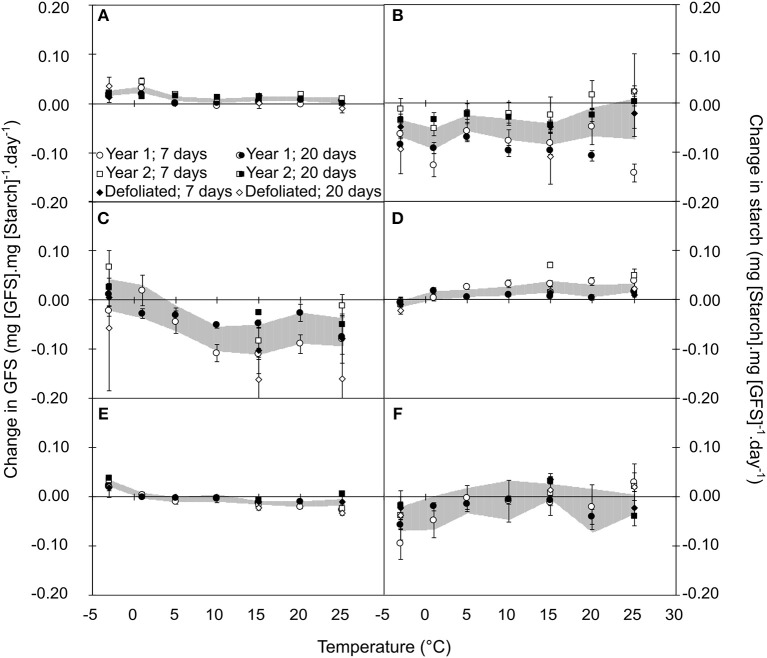
Relative variation in GFS (A,C,E) and Starch (B,D,F) normalized by Starch and GFS, respectively, after 7 (open symbols) and 20 days (closed symbols) of constant temperature treatment during autumn (A,B), winter (C,D), and spring (E,F). Each point represents the mean and standard error of n = 5 replicates (year 1 and 2) or n = 3 replicates (defoliated trees). Shaded areas represent the confidence interval at 95% for the bulk of six cases, to indicate the general trend.